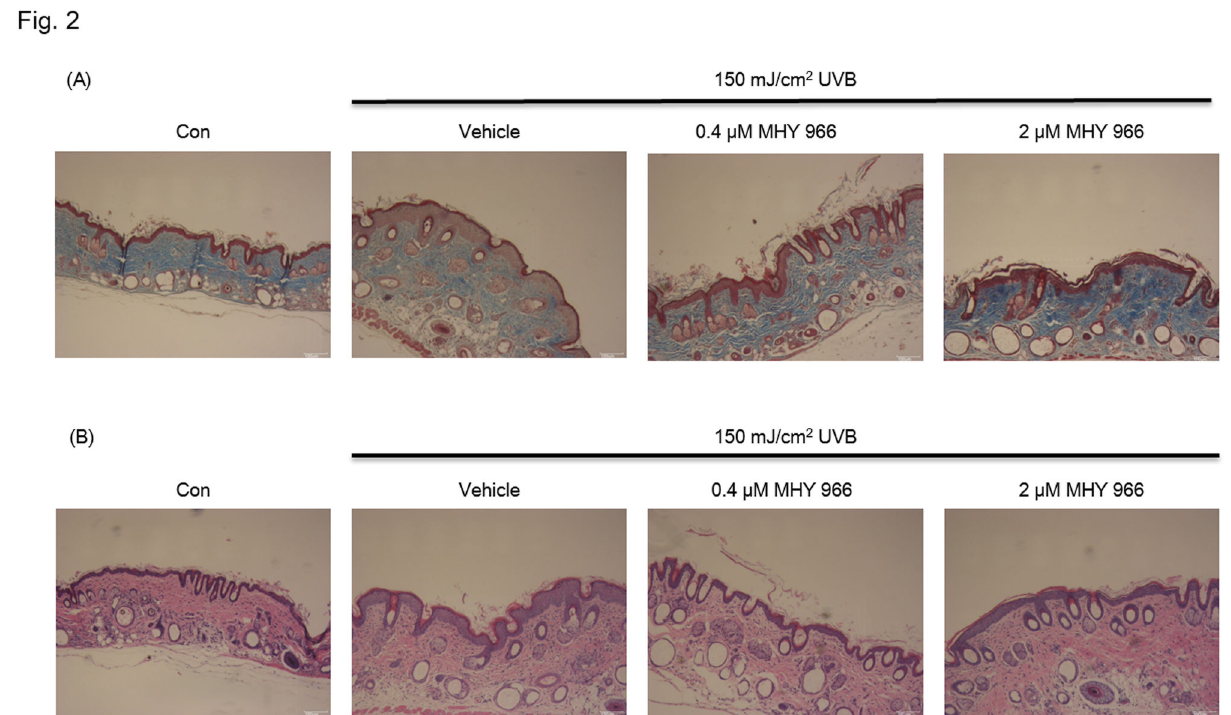
Figure 2. Effects of the topical administration of MHY 966 on UVB-induced epidermal thickness and collagen destruction in HRM2 mouse dorsal skin. Histological sections of mouse dorsal skins were stained with Masson-trichrome for dermal collagen fibrates (A). Paraffin sections were photographed after H&E staining for UVB induced skin damage (B). Original magnification: 200